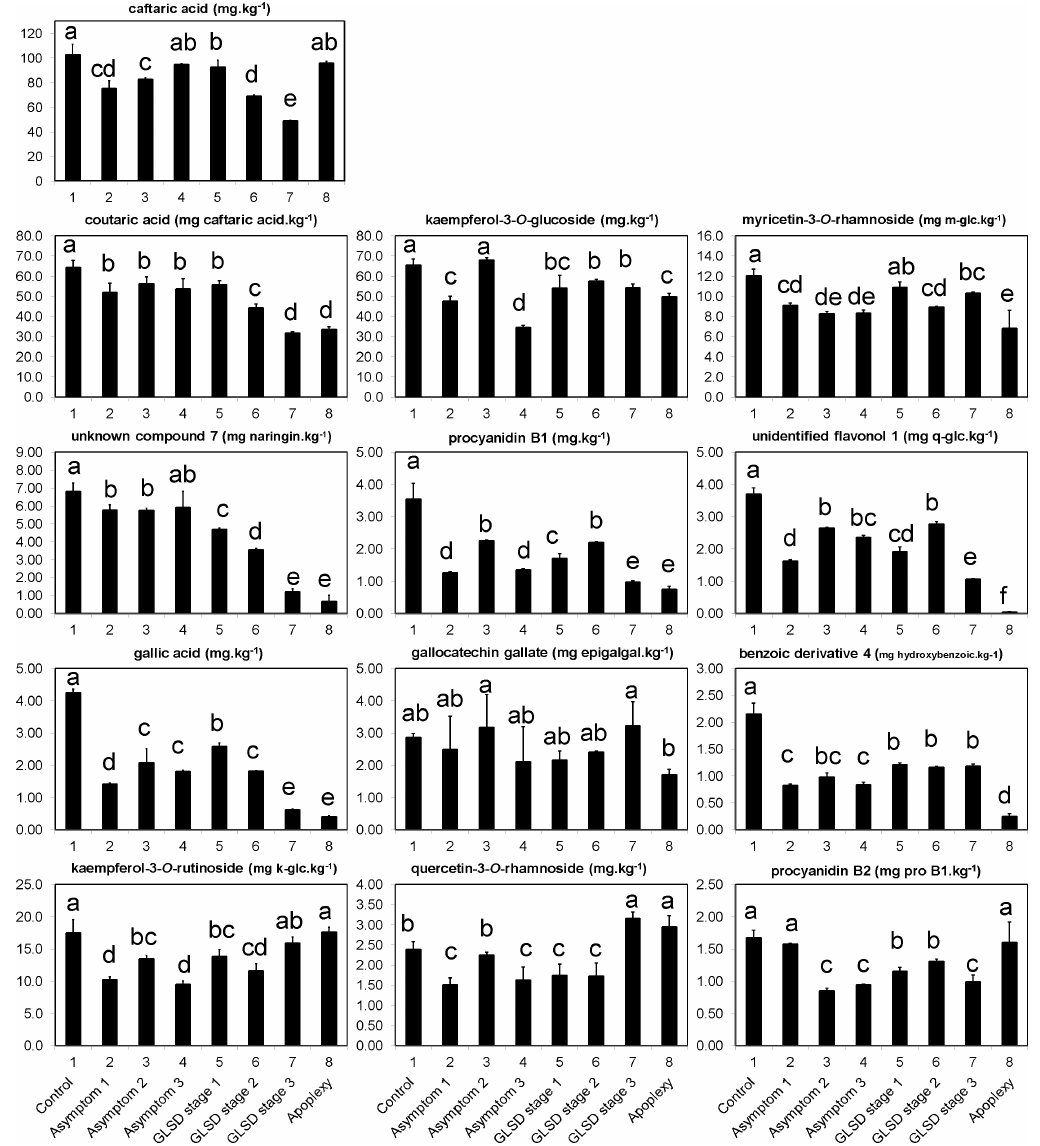
Figure 3. Phenolic compounds in asymptomatic and symptomatic leaves of vines affected by brown wood streaking, grapevine leaf stripe and apoplexy, with the highest levels (dry weight basis) in control leaves. The legend is as in Figure 6. Error bars = standard deviations ( n = 4); di ff erent letters above the columns denote statistical di ff erences (Tukey’s test; P ≤ 0.05); k-glc = kaempferol-3- O -glucoside; m-glc = myricetin-3- O -glucoside; epigalgal = epigallocatechin gallate; q-glc = quercetin-3- O -glucoside; hydroxybenzoic = hydroxybenzoic acid; and pro B1 = procyanidin